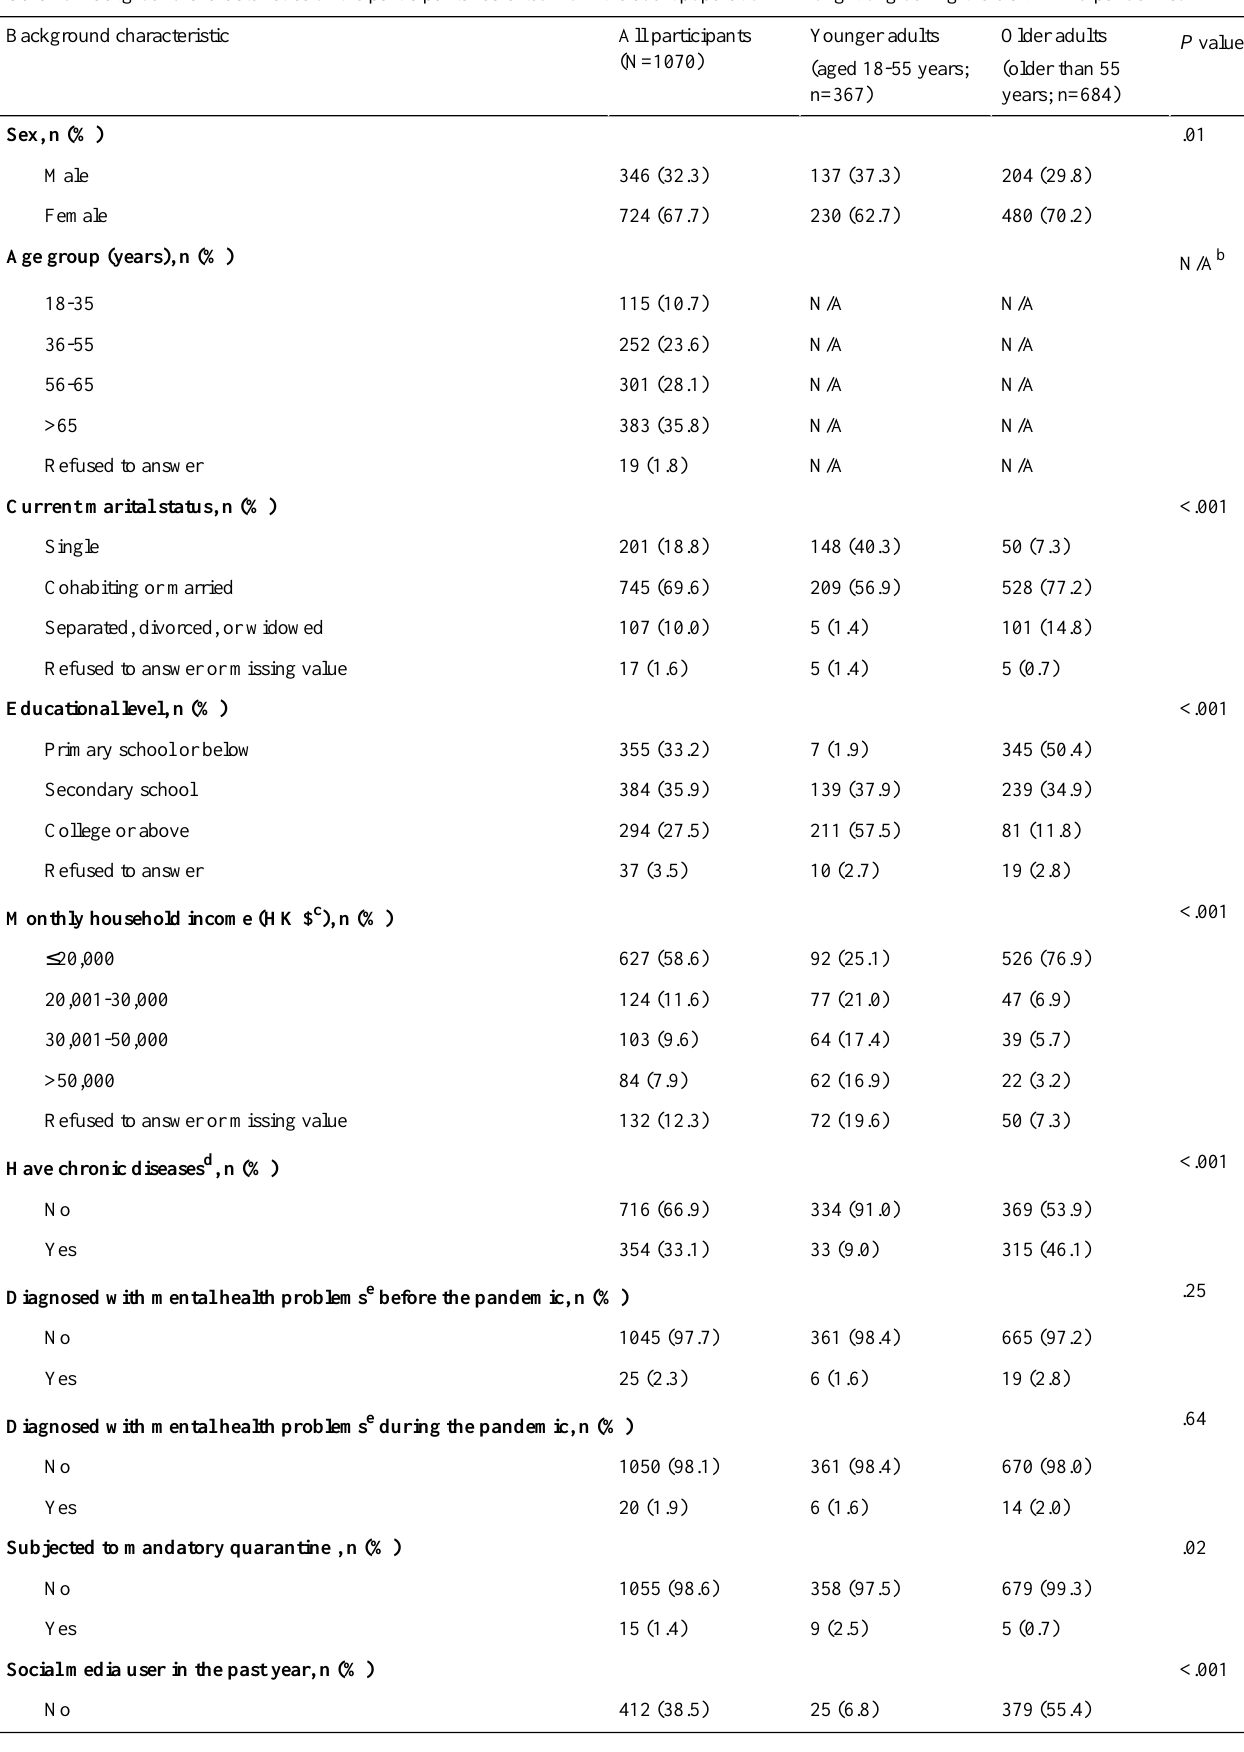
Table 1. Background characteristics of the participants recruited from the adult population in Hong Kong during the COVID-19